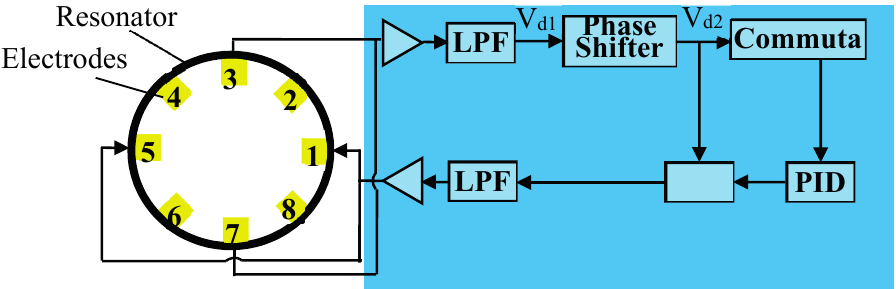
Figure 5. Electrical diagram of the driving